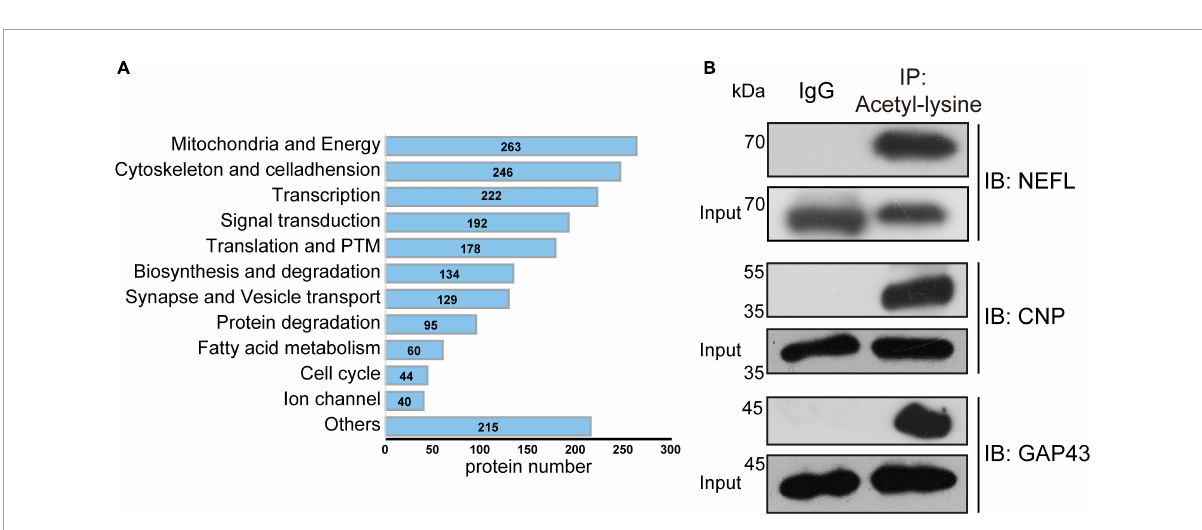
FIGURE7 Manual annotation and verification of acetylated modified proteins in the mouse brain. (A) The bar chart depicted the 12 categories of acetylated proteins classified by manual annotation. The number indicated the acetylated proteins in each category. (B) Verification of